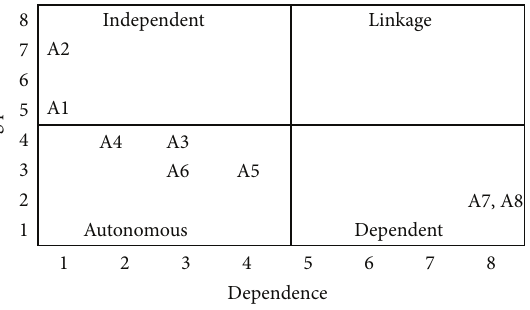
Figure 10: Cause-effect diagram of model 1.